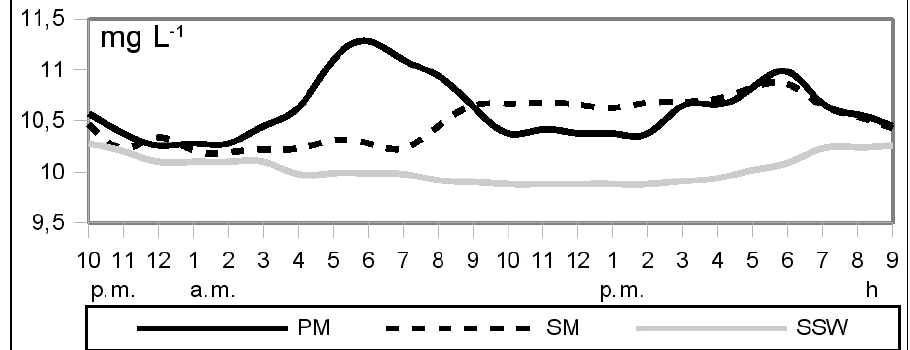
Figure 6. Diurnal variation in the oxidation-Mn (µg O